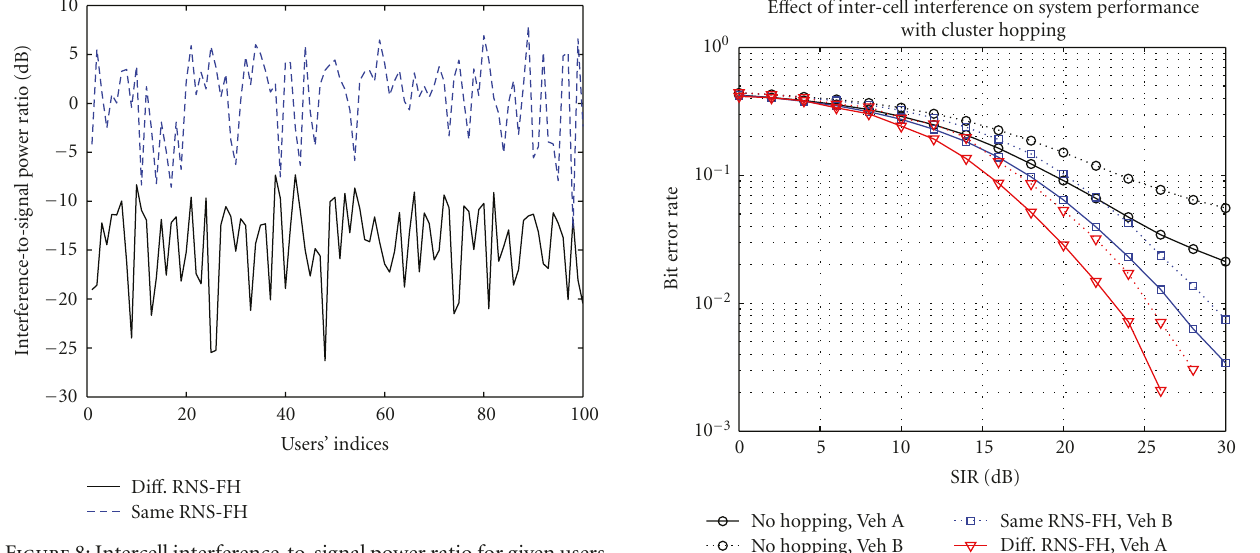
Figure 8: Intercell interference-to-signal power ratio for given users under di ff erent RNS-FH patterns and identical RNS-FH patterns assignments across cells. Figure 9: BER versus SIR of RNS-FH OFDMA under cluster hopping with di ff erent channel conditions. N = 110, M = M c = 10, N c = 11, SNR = 25dB, f D T s = 0 . 01.